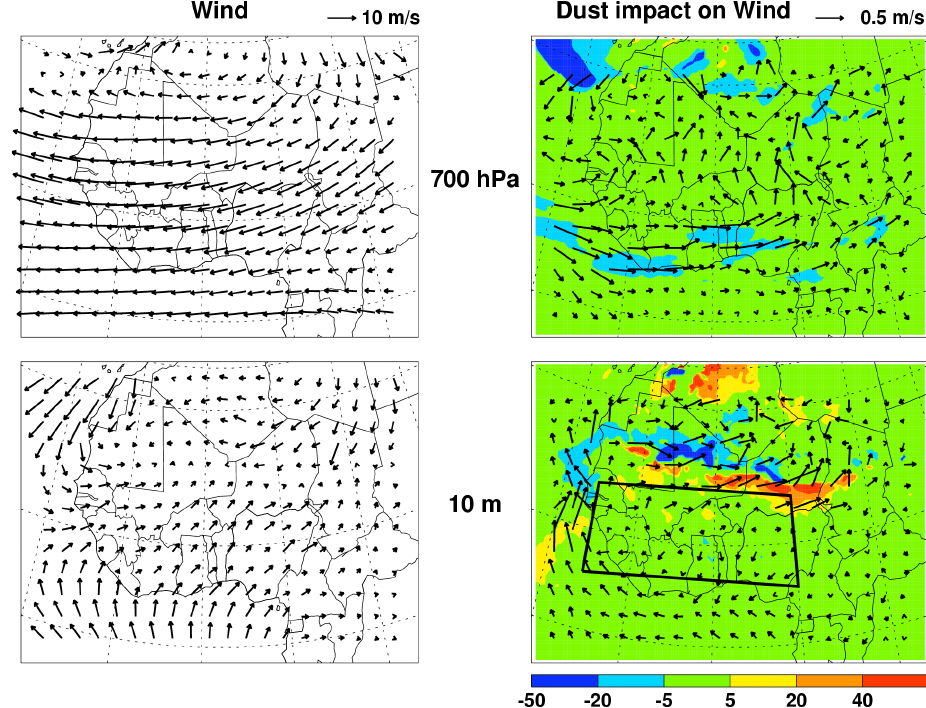
Figure 11 Spatial distributions of wind and dust-induced wind changes at 10 m and 700hPa over West Africa from WRF-Chem. The wind is from the control simulation with dust; the dust-induced wind changes are estimated by subtracting the simulation without dust from that with dust. Dust-induced wind speed changes in percentage are also shown as contour. The region in the black box is defined as the West Africa Monsoon (WAM) region.